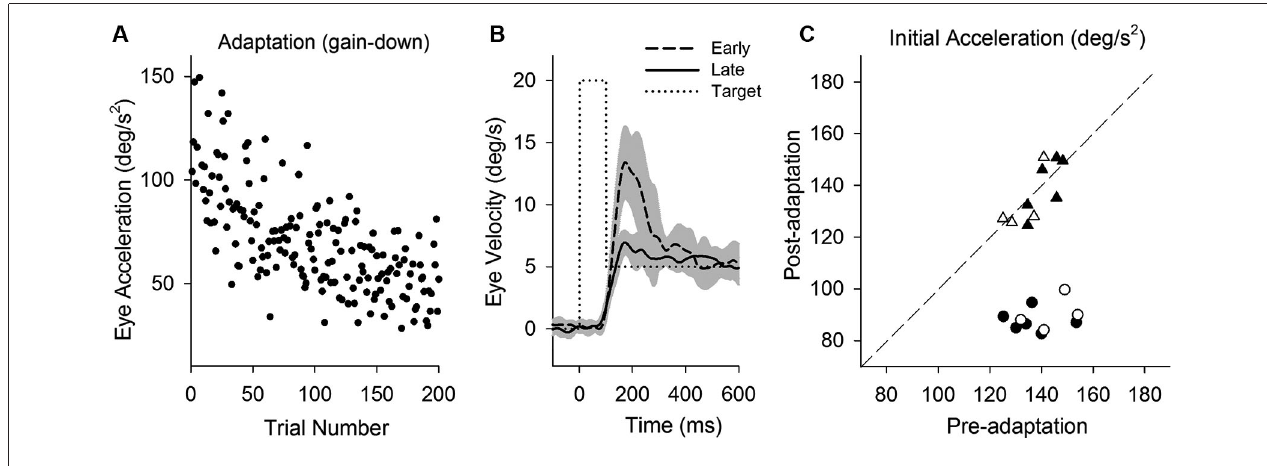
stepped down to 5 ◦ /s (dotted line). (C) Mean eye acceleration values (first 100 ms) show significant adaptive changes in the direction of a step-down paradigm (circle symbols) but not in the control direction (triangle symbols). Open and filled symbols indicate monkey-P and B,